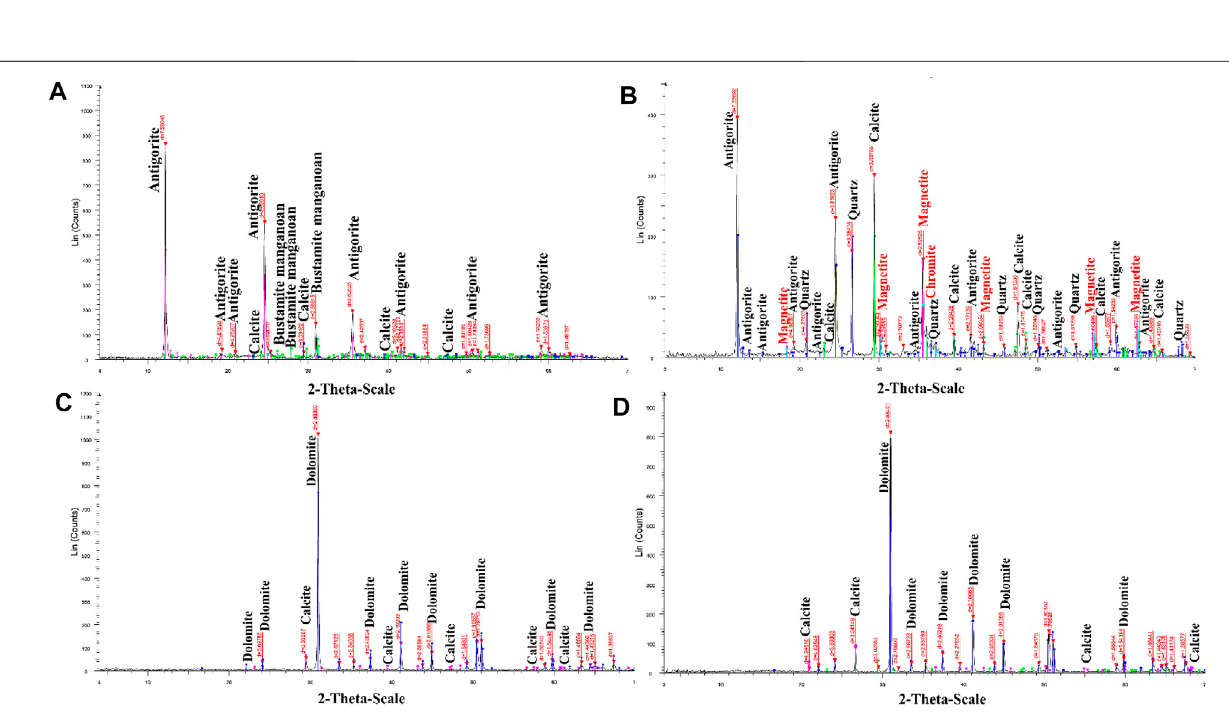
Frontiers in Earth Science | www.frontiersin.org July 2022 | Volume 10 | Article 894582